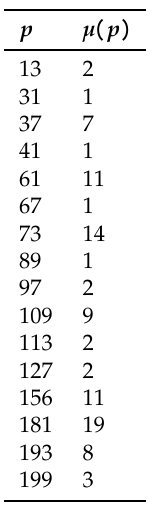
Table 4. Nonzero values of µ ( p ) .